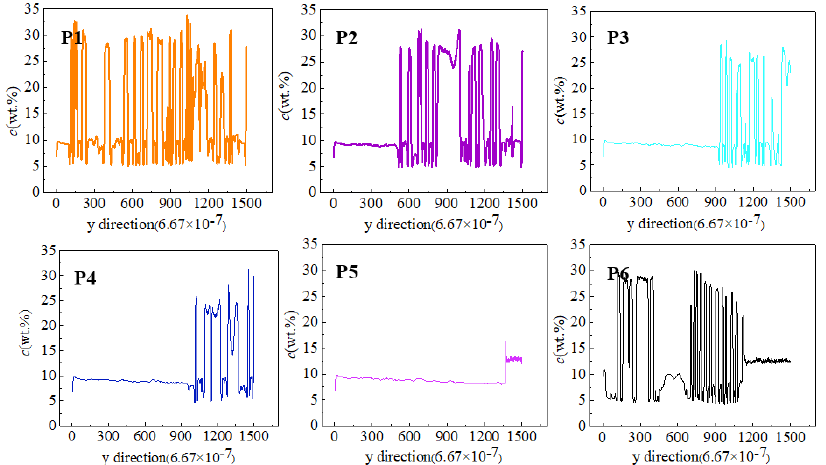
Figure 11. Variation of concentration on the axis of vertical columnar crystal at different positions.